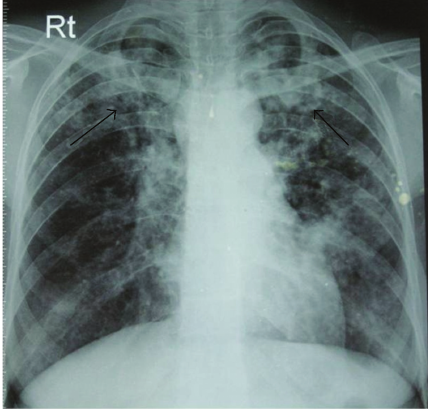
Figure 1: Initial chest radiograph showing bilateral infiltrates (arrows).